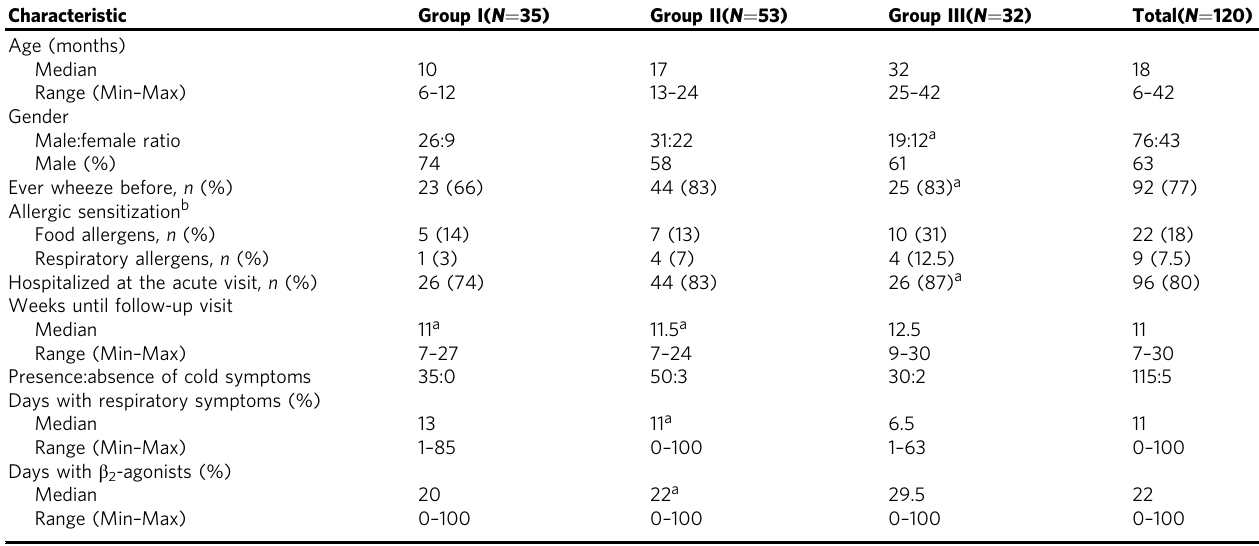
Table 1 Demographic and clinical characterization of wheezing children